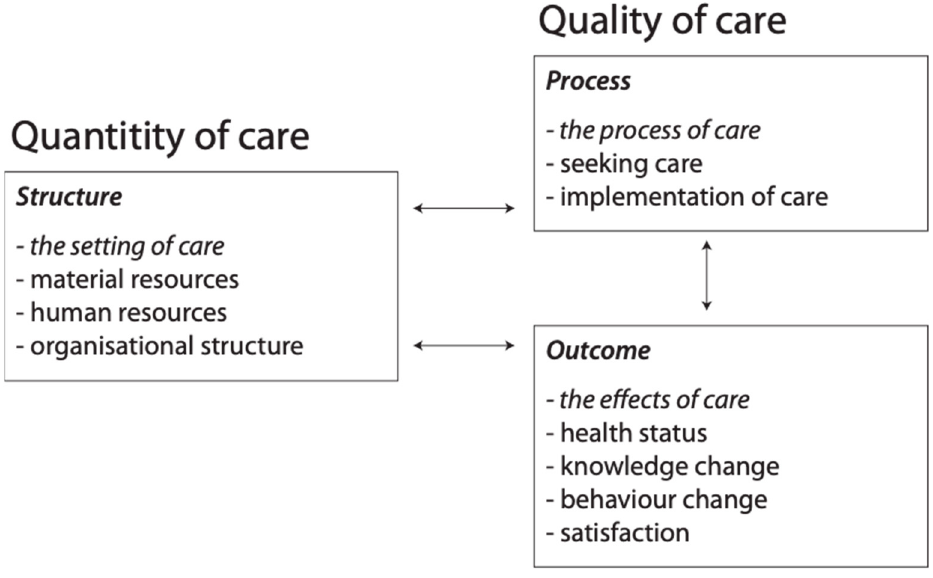
Figure 1. Quantity and quality of care [62]